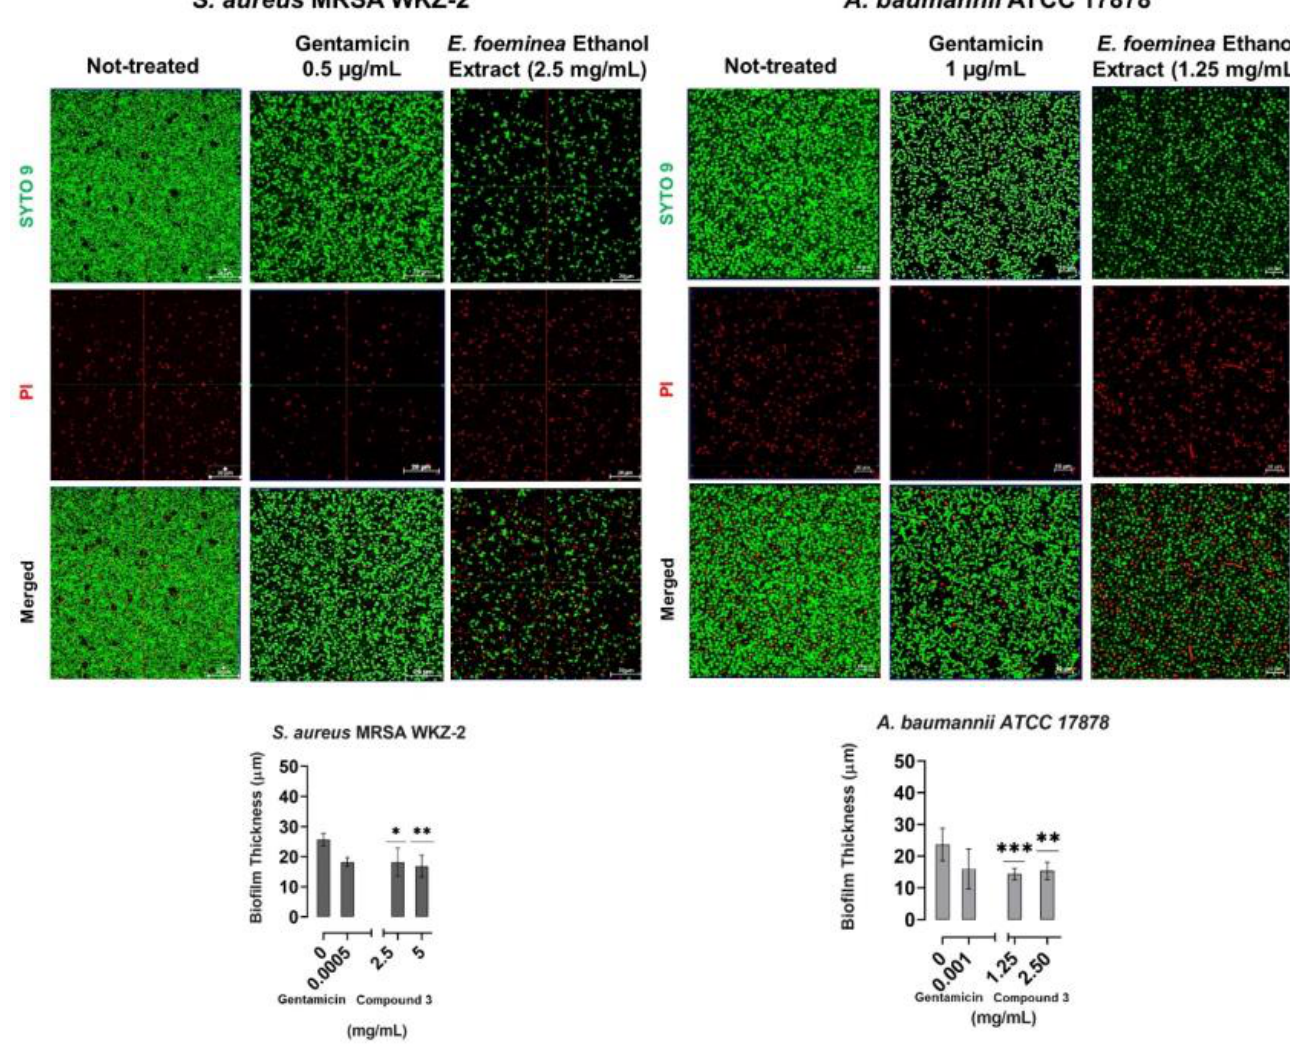
Figure 6. Antibiofilm activity of E. foeminea ethanolic extract. Effects of E. foeminea ethanolic extract